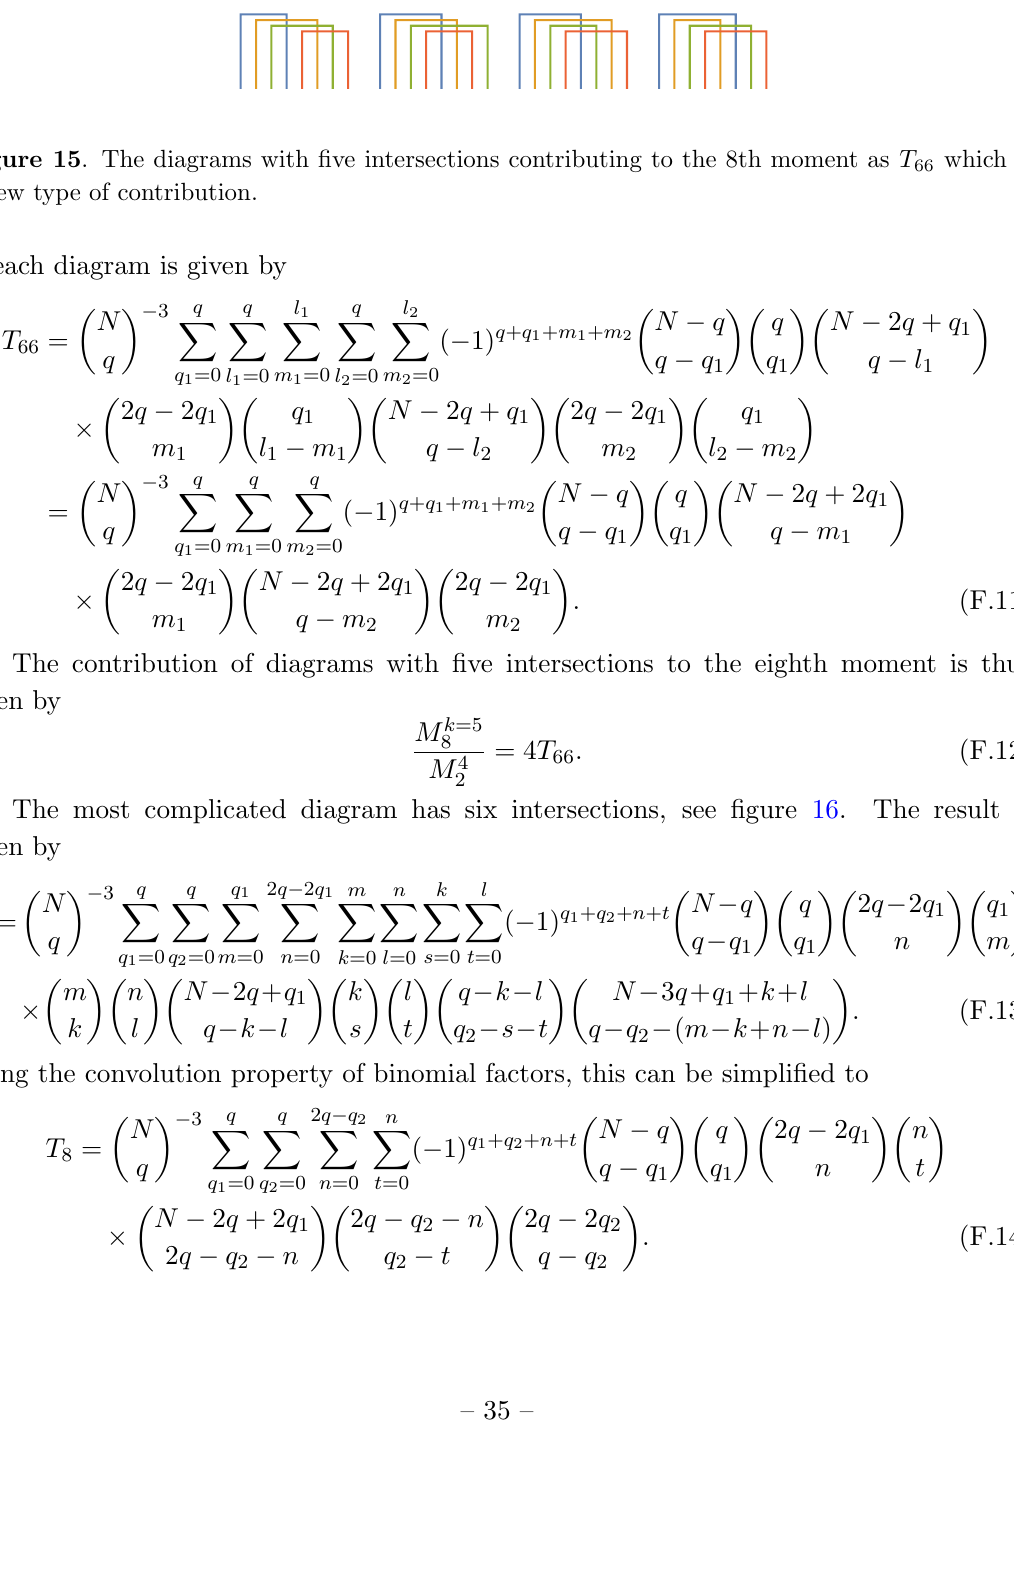
Figure 14 . Diagrams with four intersections contributing to the 8th moment as (cid:17)T 6 .